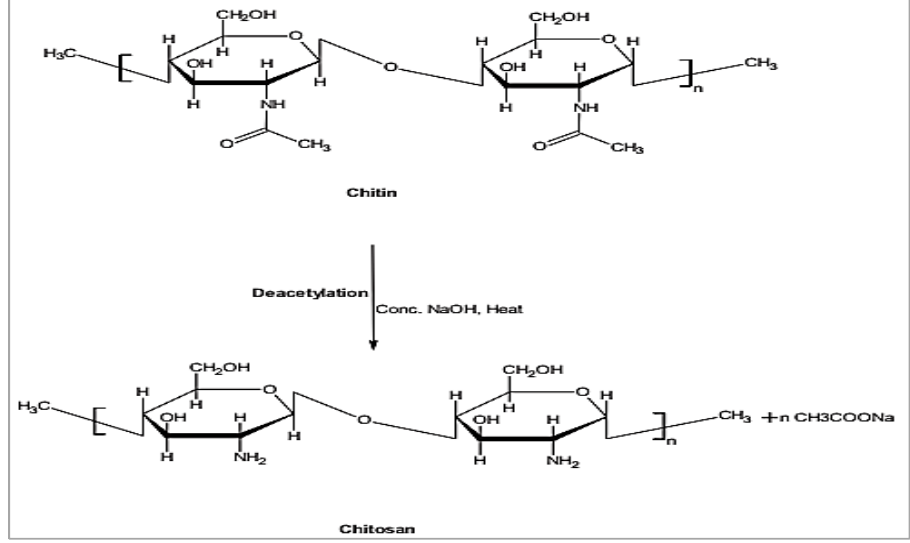
Figure 2. Deacetylation of chitin to chitosan. Adapted with permission from [106].